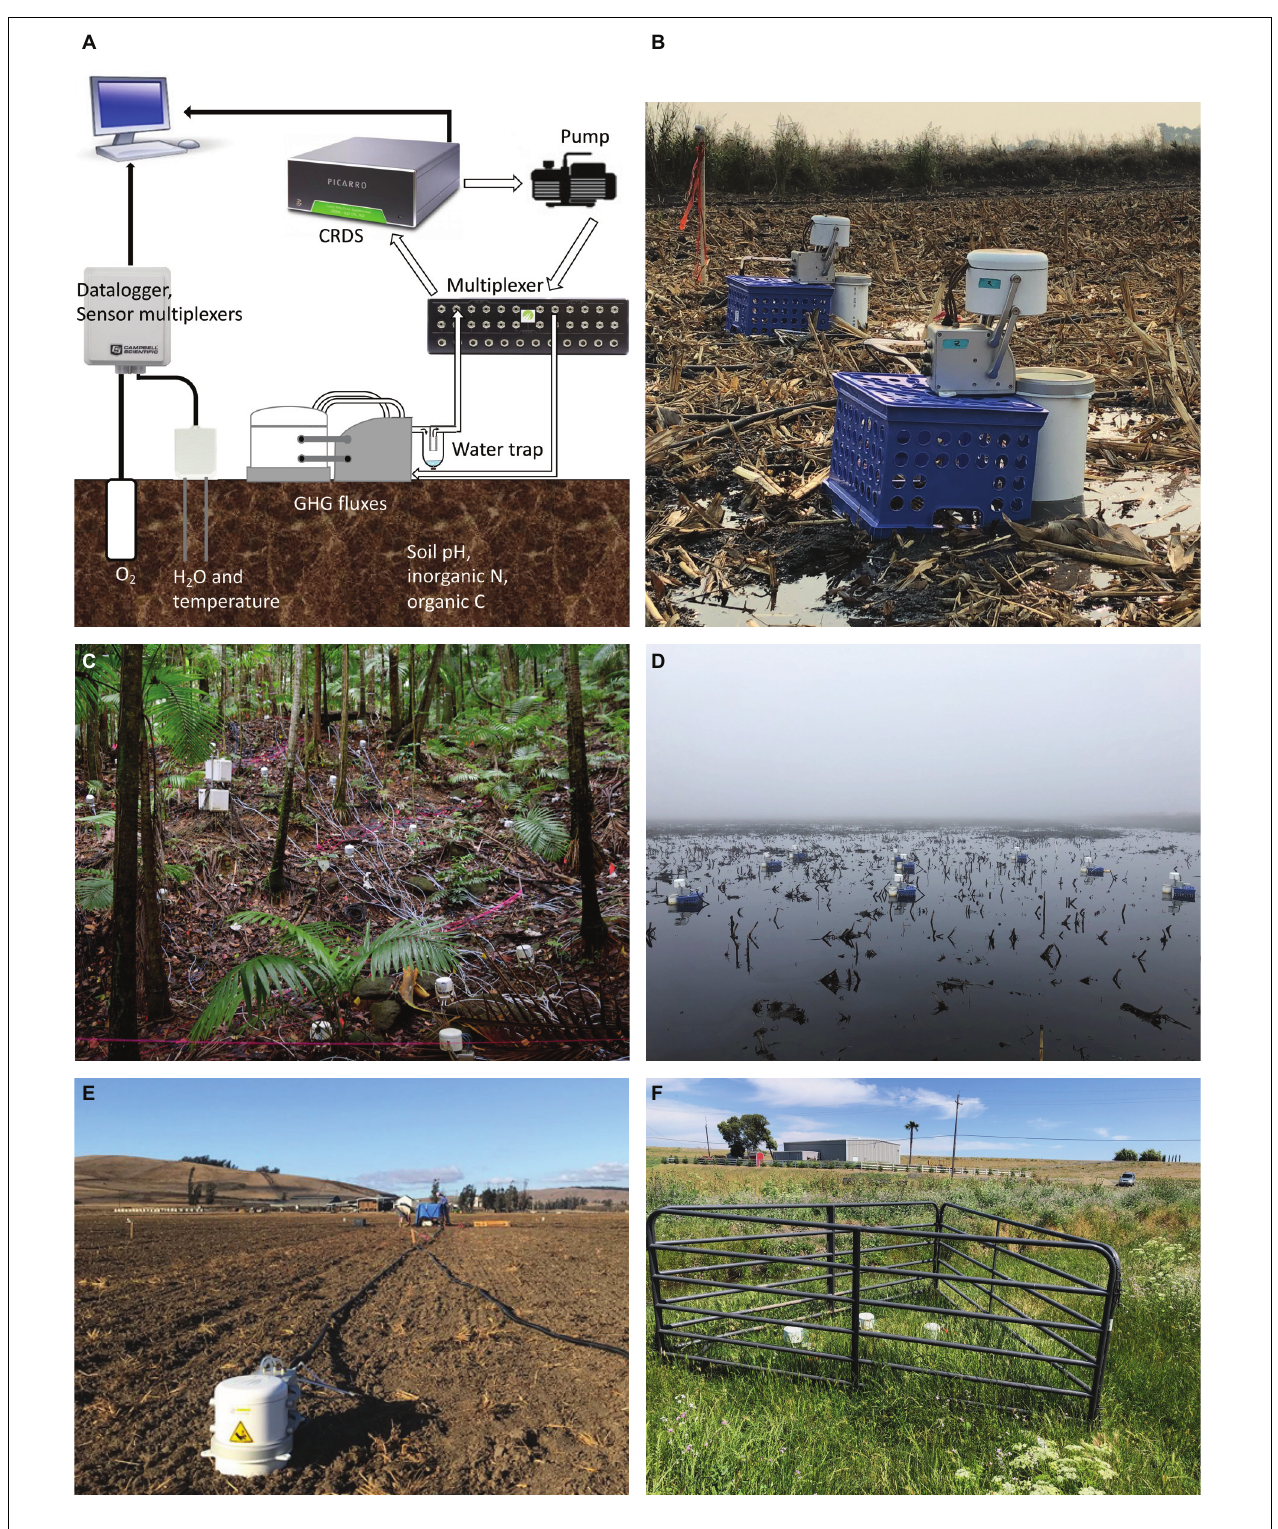
FIGURE 1 | (A) Sampling configuration for continuous soil GHG emissions by CRDS and applicable soil physicochemical variables (in this case, e.g., soil moisture, temperature, and oxygen sensors). A circulating pump draws air after chamber enclosure. The air passes through a multiplexer where is directed to the CRDS for pseudo-continuous GHG concentration measurements. (B–F) Field deployment of automated CRDS systems including in tropical high-rainfall ecosystem [Luquillo Experimental Forest, Puerto Rico (C) ], in flooded soils [California, United States (B,D) ] and agricultural systems [California, United States (E,F) ].